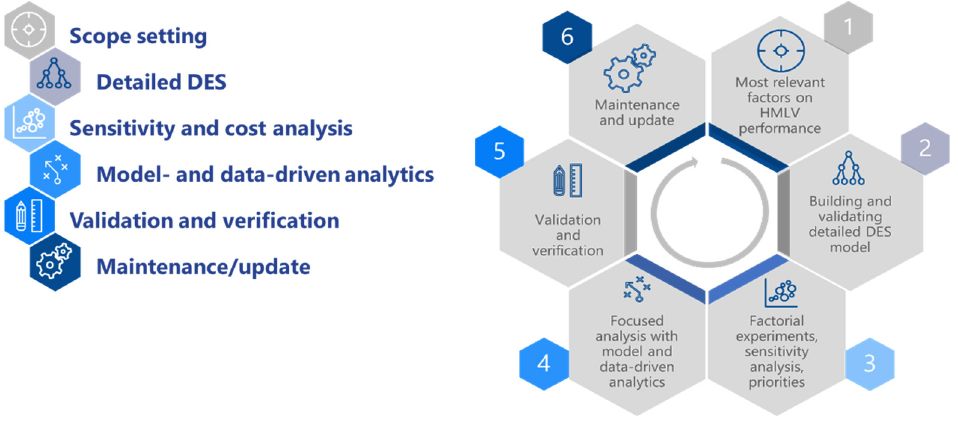
Figure 6. The basic decision support workflow.